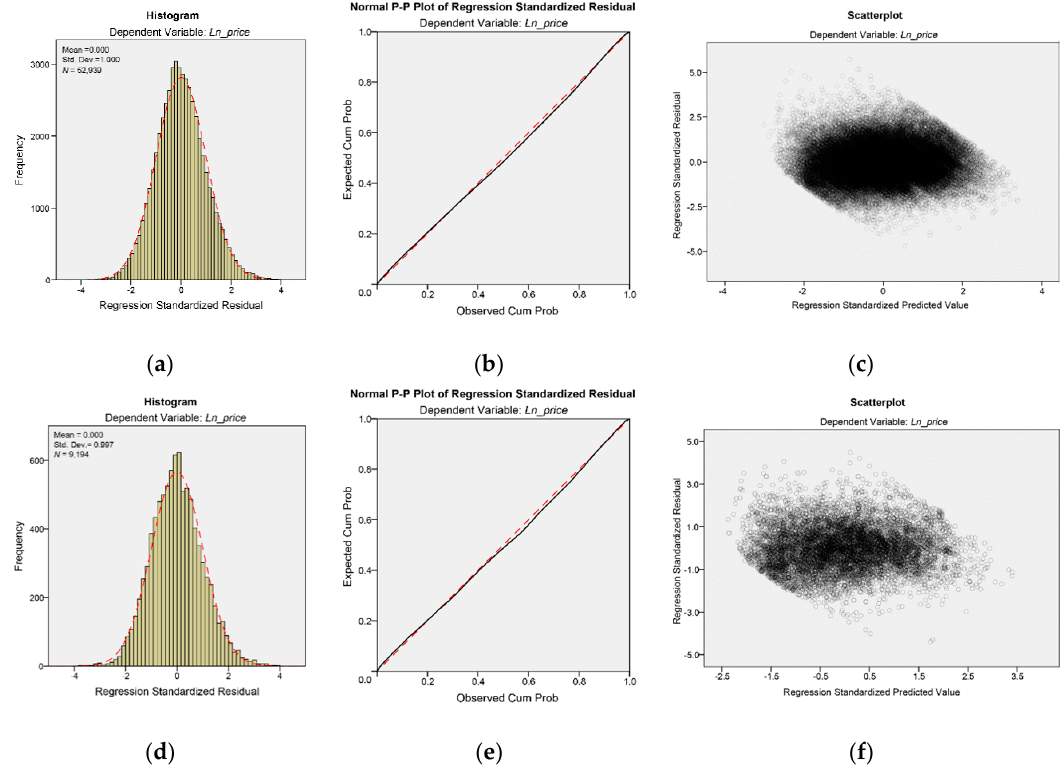
Figure 7. Graphs of the estimation 3: ( a ) histogram and normal curve of the standardized residual error; ( b ) P-P plot of residual normality; ( c ) scatter plot of the predicted values and standardized errors. Graphs of the estimation 4: ( d ) histogram and normal curve of the standardized residual error; ( e ) P-P plot of residual normality; ( f ) scatter plot of the predicted values and standardized errors.